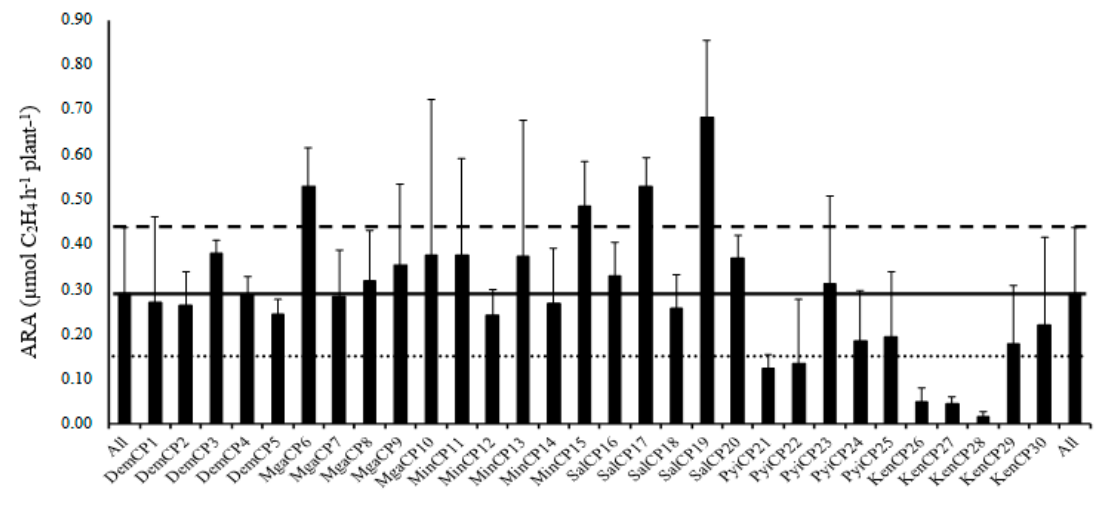
Figure 3. Acetylene reduction activity per plant of Yezin4 Chickpea ( Cicer arietinum ) variety inoculated with 30 purified Mesorhizobium strains after four weeks, Bars mean standard deviation levels. The middle line indicates average acetylene reduction activity per plant of all strains; the upper line means the higher acetylene reduction activity per plant and the lower line refers the lower acetylene reduction activity per plant of all strains.